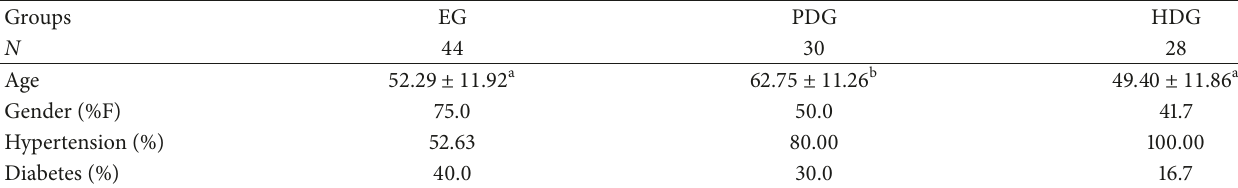
Table 1: Demographic data of the study population according to the groups.